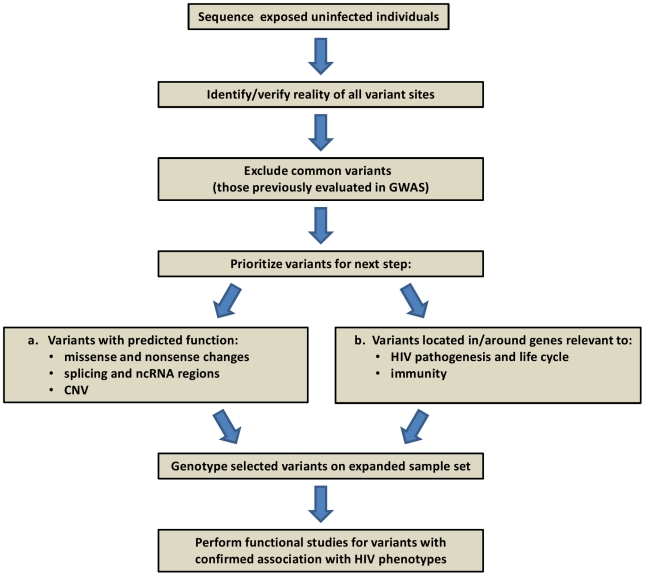
Project framework: human genome resequencing of hemophilia A individuals exposed to HIV-contaminated factor VIII in 1979–1984, yet uninfected.